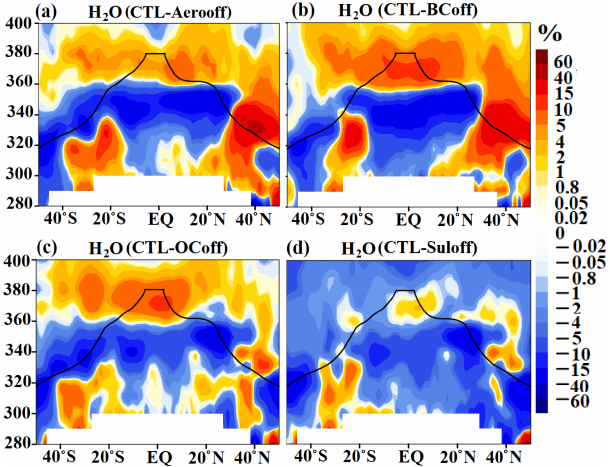
Figure 7. (a) Meridional cross-section over the Indian Ocean– western Pacific (averaged over 30–140 ◦ E) of anomalies of water vapor (%) (CTL-Aerooff) for the spring season for the years 2001– 2016. (b) Same as (a) but from CTL-BCoff simulations. (c) Same as (a) but from CTL-OCoff simulations. (d) Same as (a) but from CTL-Suloff simulations. A black line in (a–d) indicates the dynam- ical tropopause.